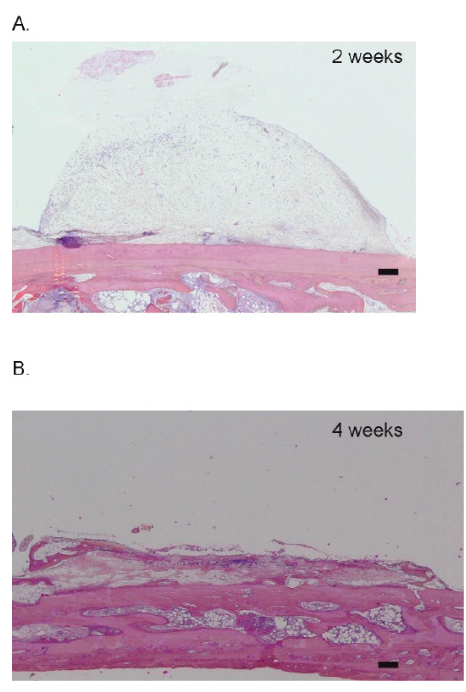
Figure A1. Sham sites at 2 and 4 weeks. Representative pictures at ( A ) two weeks (n = 4) and ( B ) four weeks (n = 4). Black bars: 100 µm.